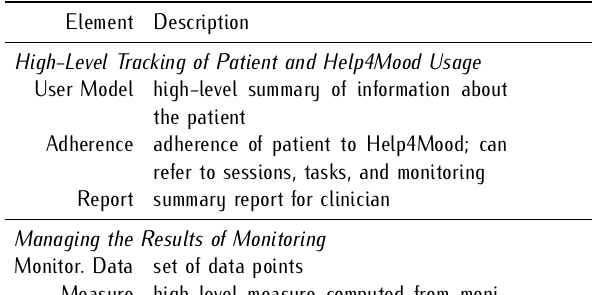
Table 1. Basic Elements of the Help4Mood data structure. Each one is defined using